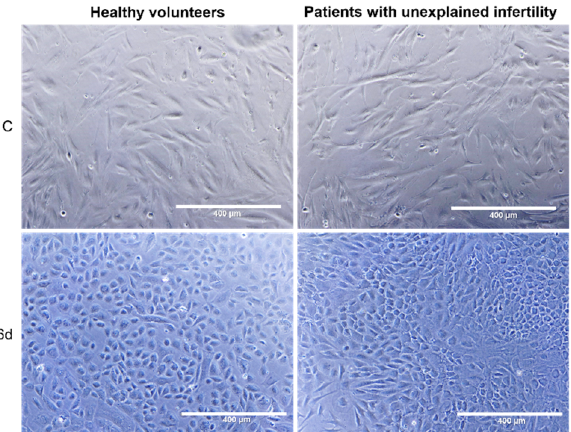
Figure 3. Morphology of menstrual stem cells differentiation into epithelial cells. C—control cells, 6d—cells after 6 days of culture in differentiation medium. Scale bar: 400 µm (10× objective).